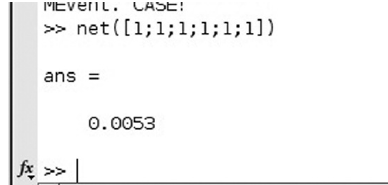
Fig. 7. Neural network answer with a clearly incorrect solution